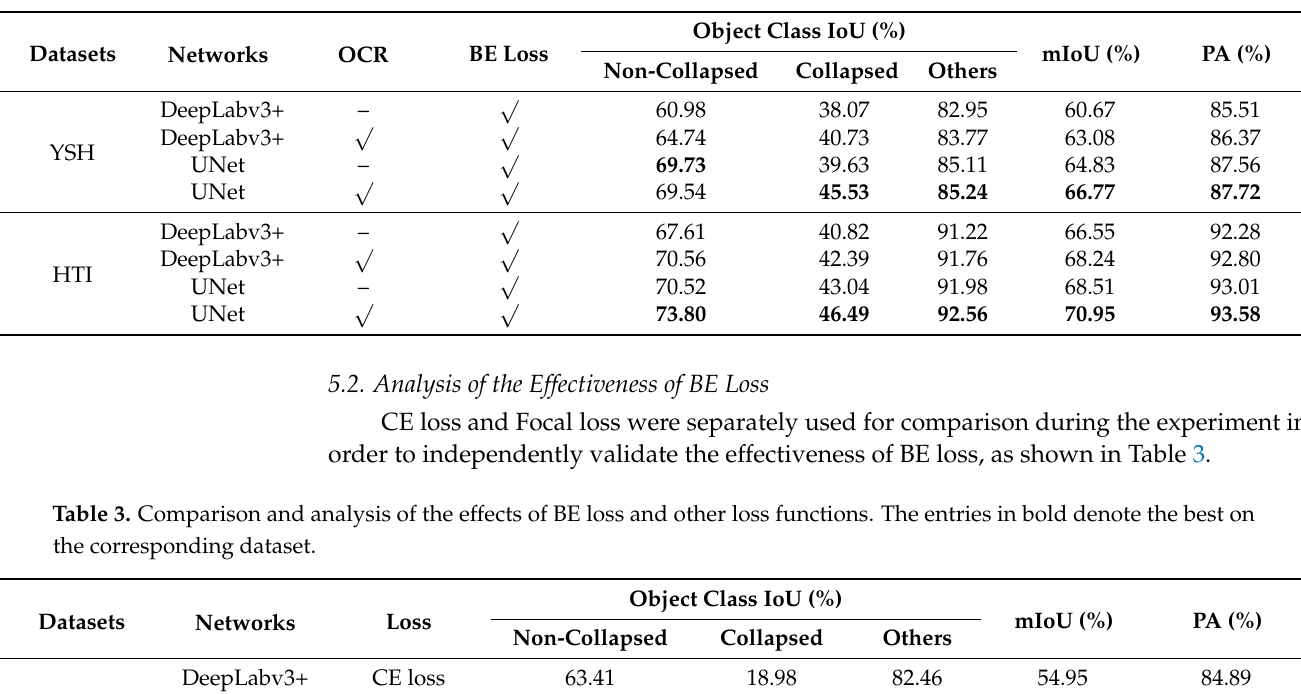
Table 2. Analysis of the embedment effect of the OCR module. The entries in bold denote the best on the corresponding √ dataset. and—Separately represent that a module is used and not used.